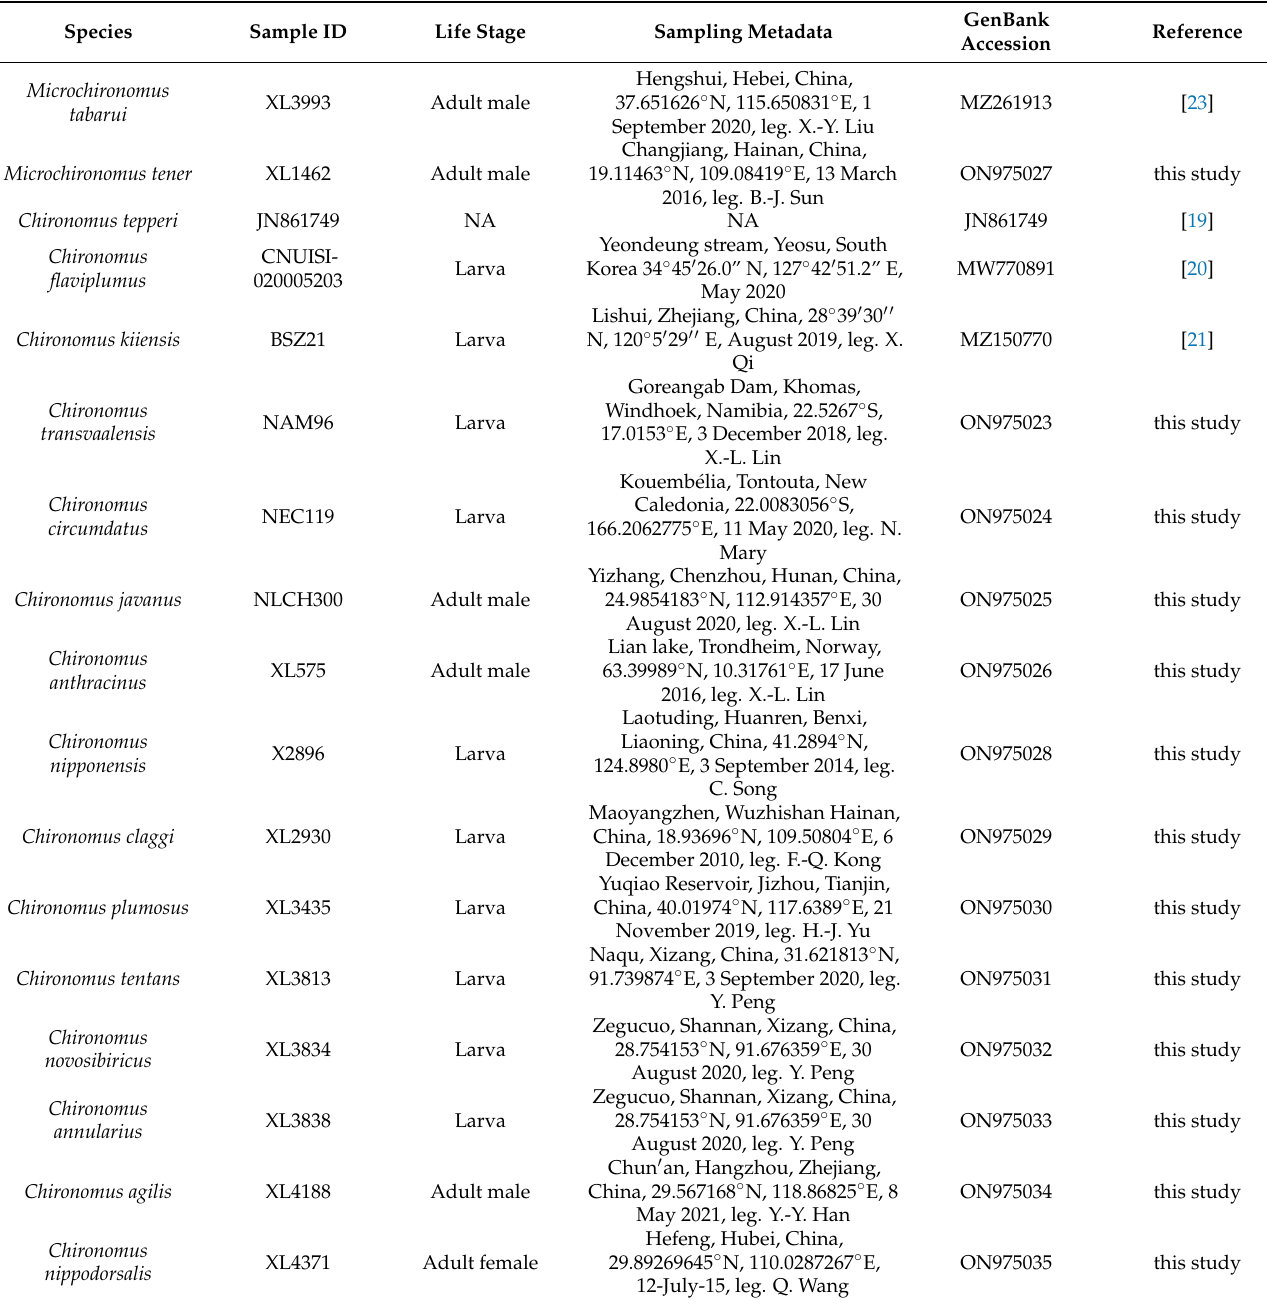
Table 1. Detailed information of 15 Chironomus and two Microchironomus species used in the